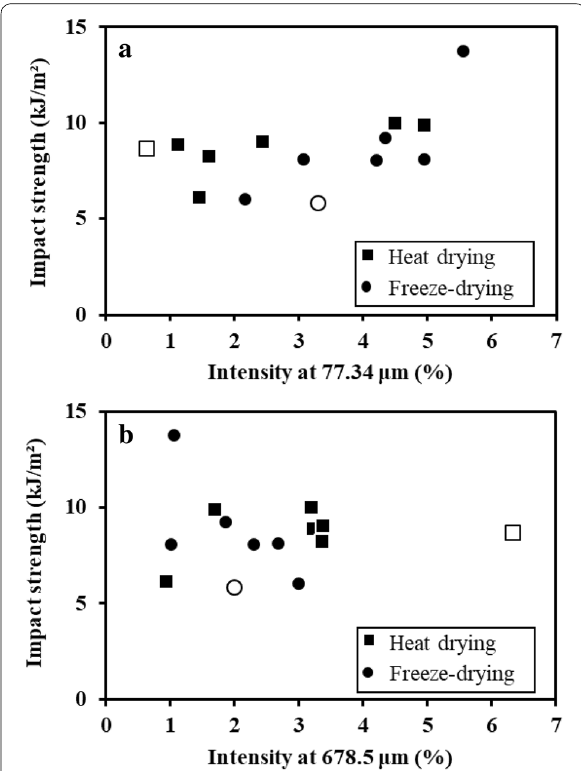
Fig. 8 The relationship between tensile strength of WPC and intensity of the particle size distribution analysis at a 77.3 µm and b 678.5 µm. Open square, heat drying 0 min and open circle, freeze-drying 0 min